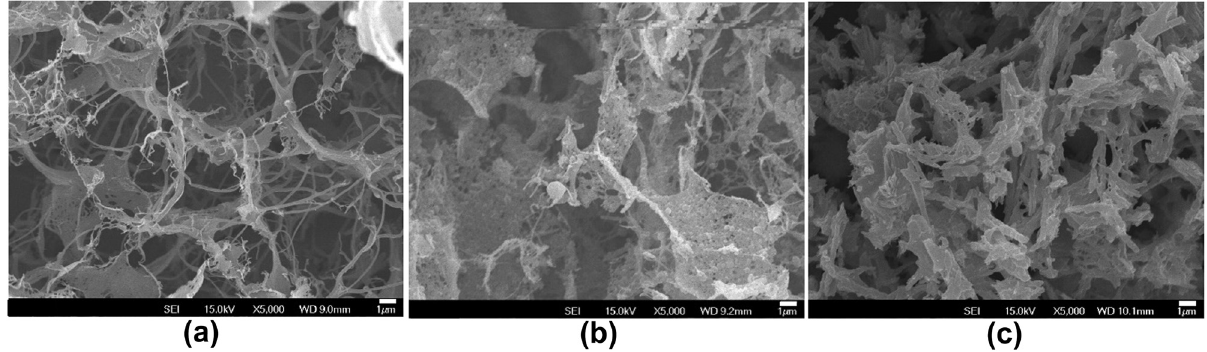
Figure 7: SEM images of ( a ) Fmoc - FF 1%, ( b ) Fmoc - FF 0.91% – PAMAM 0.09% hydrogels, and ( c ) Fmoc - FF 0.8% – PAMAM 0.2% ( did not gel but precipitated ) . The scale bar is 1 µm.